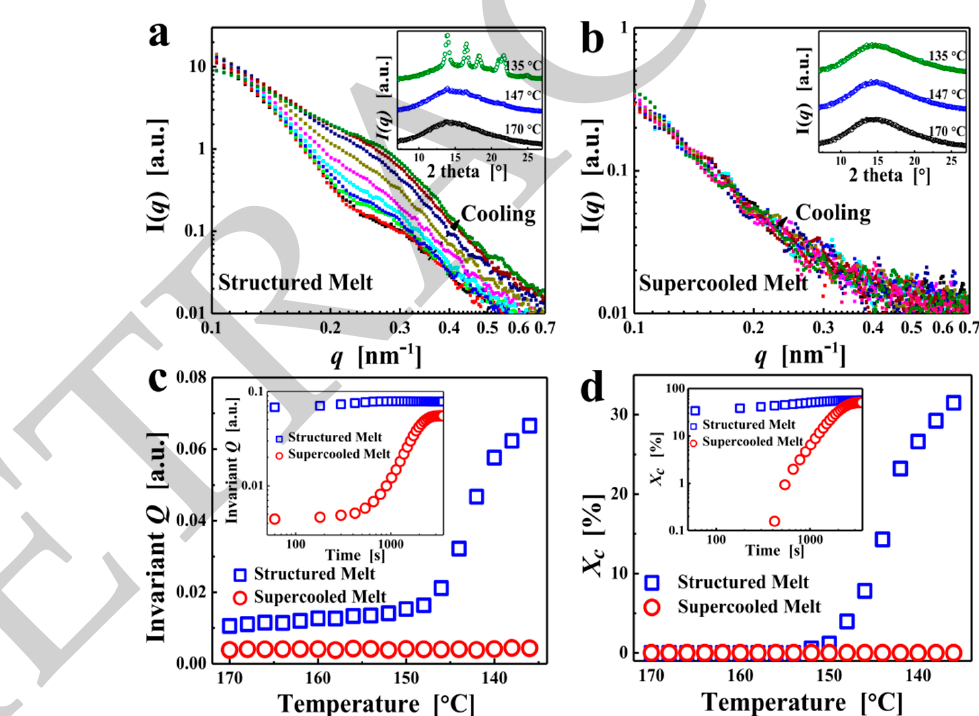
Figure 5. The structure evolution of the iPP samples during the cooling process from both the structured and supercooled melts. The selected SAXS profiles were derived from the cooling process: ( a ) from the structured melt (partially melted iPP with the thermal history shown in Figure 1) and ( b ) from the supercooled melt; three selected WAXS profiles were shown in ( a , b ), as inset, respectively. ( c ) The evolution of invariant Q derived from SAXS data and ( d ) crystallinity derived from WAXS data, both from the structured and supercooled melt. The insets in ( c , d ) were the evolution of Q and crystallinity during the isothermal crystallization at 135 °C, respectively .